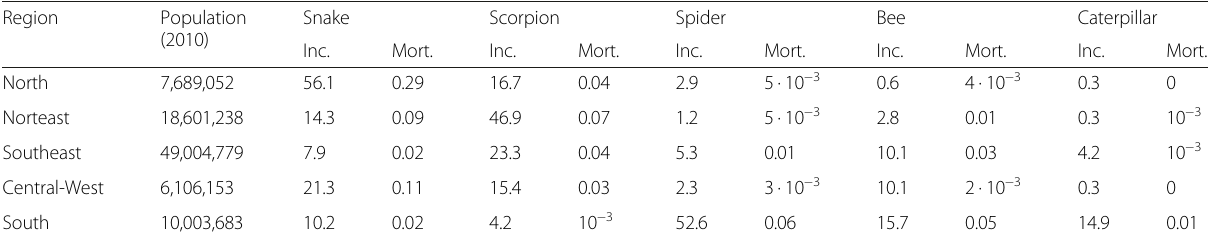
Table 5 Regional incidence and mortality (per 100,000 population) according to the zoological groups Region Population Snake Scorpion Spider Bee Caterpillar (2010) Inc. Mort. Inc. Mort. Inc. Mort. Inc. Mort. Inc. Mort. North Norteast 18,601,238 Southeast 49,004,779 Central-West